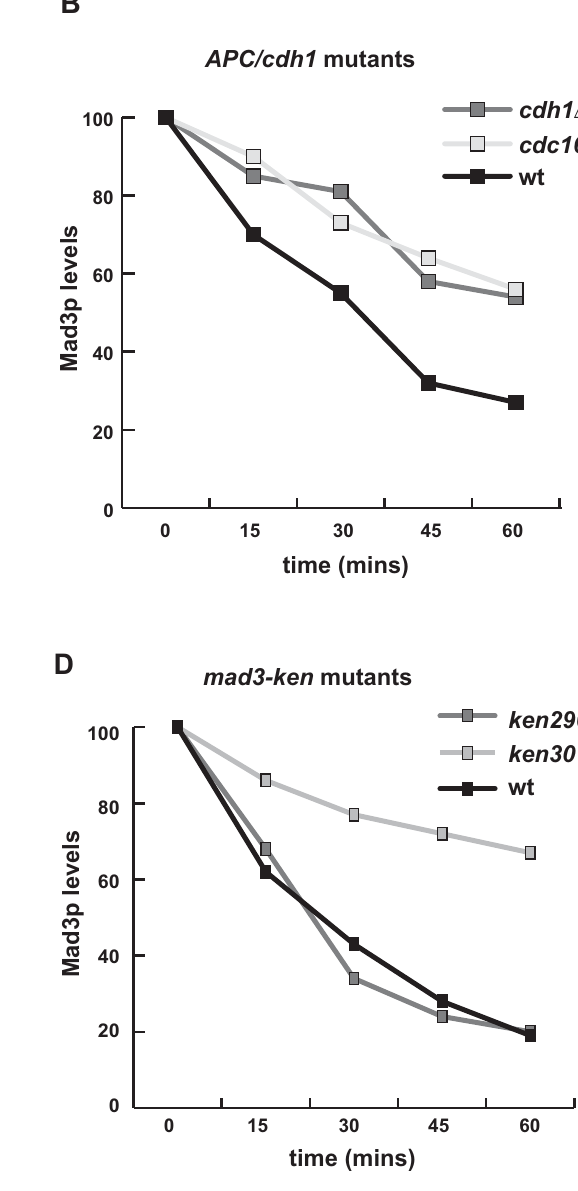
and GFP-marked chromosomes during the ensuing anaphase (Fig. 7A). This experiment demonstrated that the Mad3p- overexpressing strains exhibit chromosome mis-segregation (25– 40% for chromosome V), following release from the checkpoint